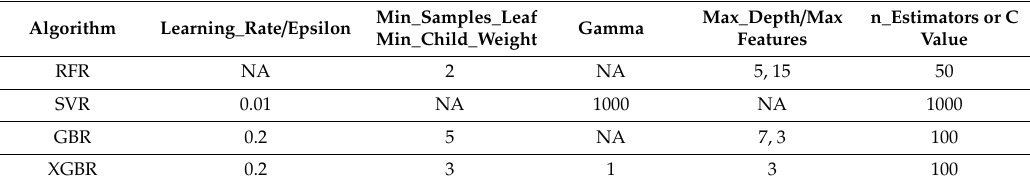
Table 4. Optimized hyperparameters of the ML applied in this